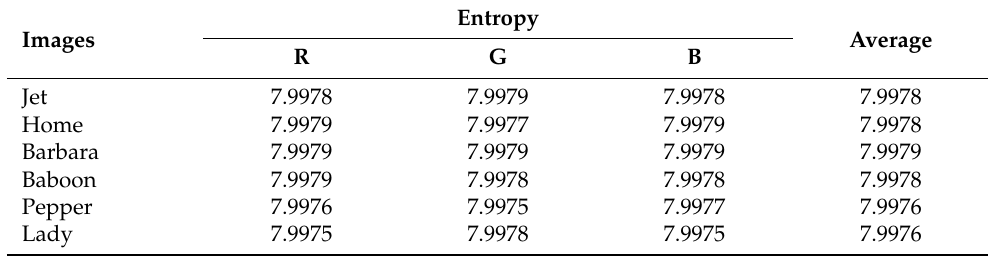
Figure 13. Entropy graph of input images and their cipher images. Table 7. Entropy value of cipher